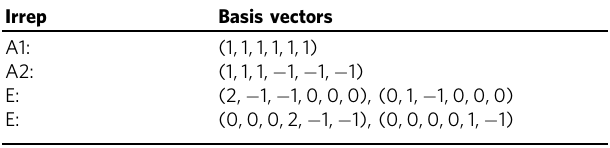
Basis vectors of the D 3 irreducible representation (Irrep) decomposition of the six dimensional linear subspace of the superconducting nearest-neighbor bond order parameters surrounding the aligned carbons, pierced by the twist rotation axis. The fi rst (last) three dimensions are for the bond order parameters in the top (bottom) layer.